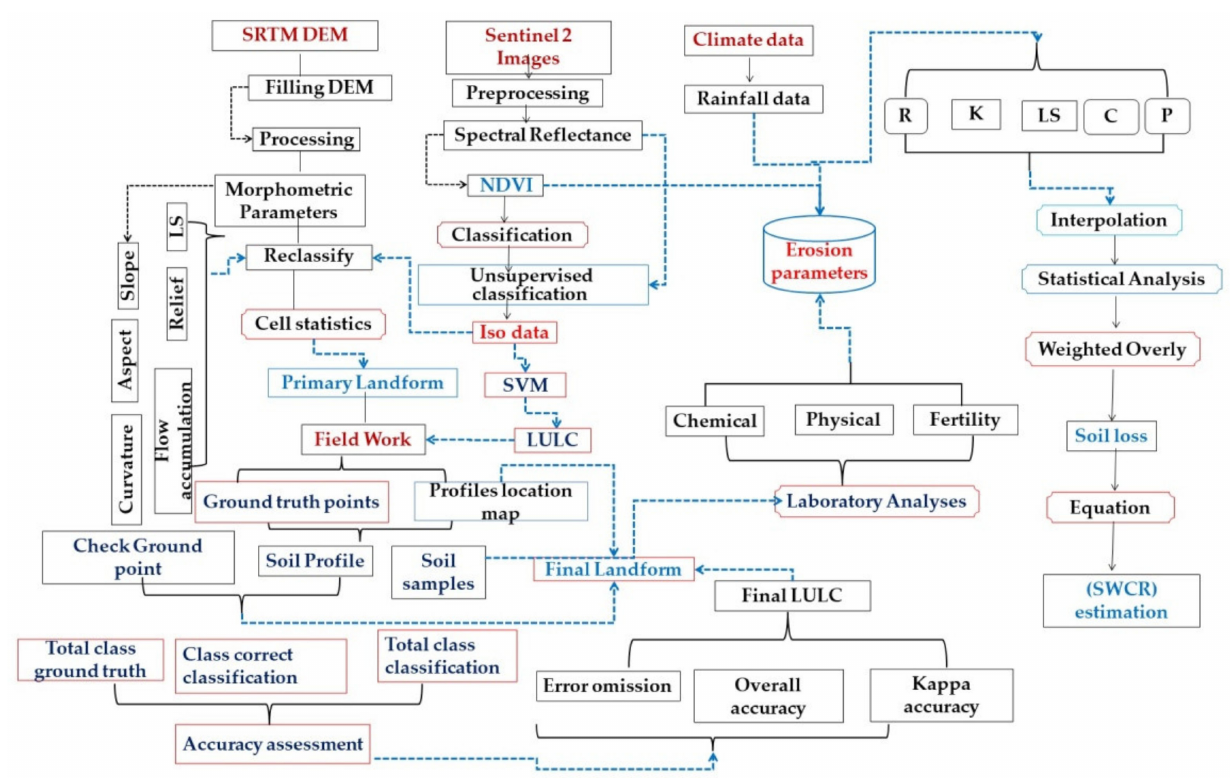
Figure 2. Current work methodology schematic